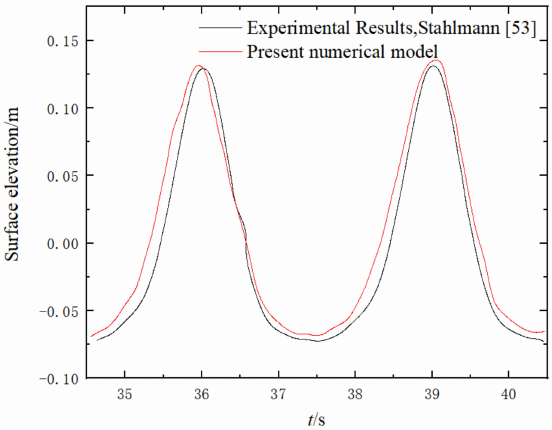
Figure 6. Comparison of surface elevation between the present study and Stahlmann [53].